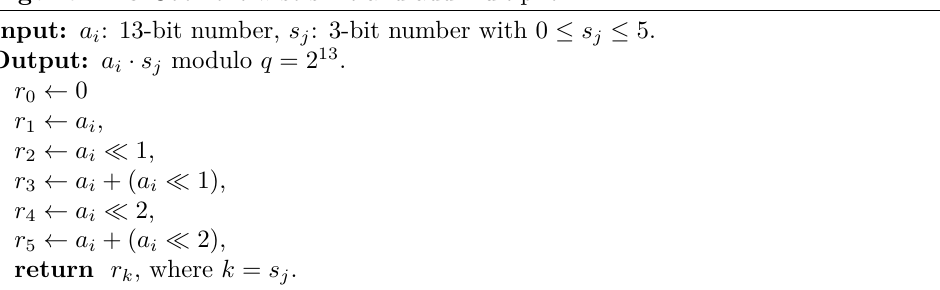
Algorithm 8 Coeffient-wise shift-and-add